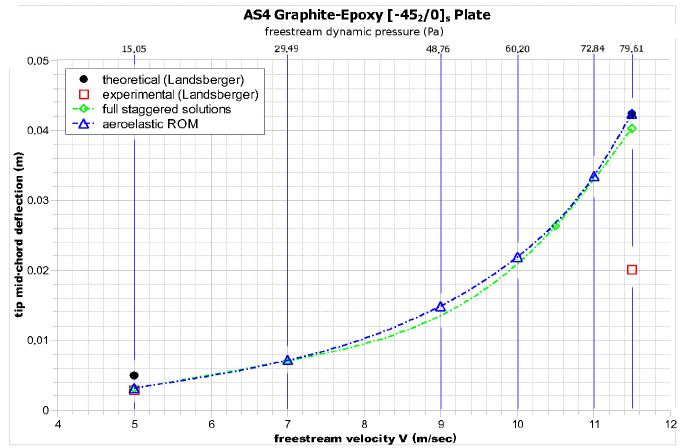
Figure 9. Tip mid-chord static aeroelastic deflection for the [ − 45 2 /0 ] s plate